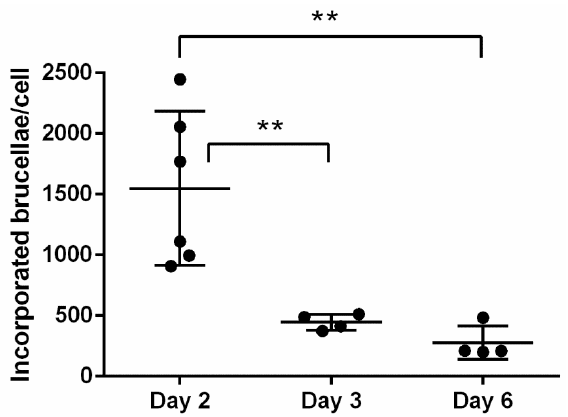
Figure 5. Summative analysis of incorporated brucellae per cell in ovine macrophages infected with Brucella at MOI = 5000, on Days 2, 3, and 6 post-infection (quantitative Real-Time PCR). Statistical comparison was performed with the one-way ANOVA and data are expressed as means ± standard deviation. Each MOI condition was repeated 6 times (six different experiments on macrophages of 6 different sheep). ** p > 0.005.